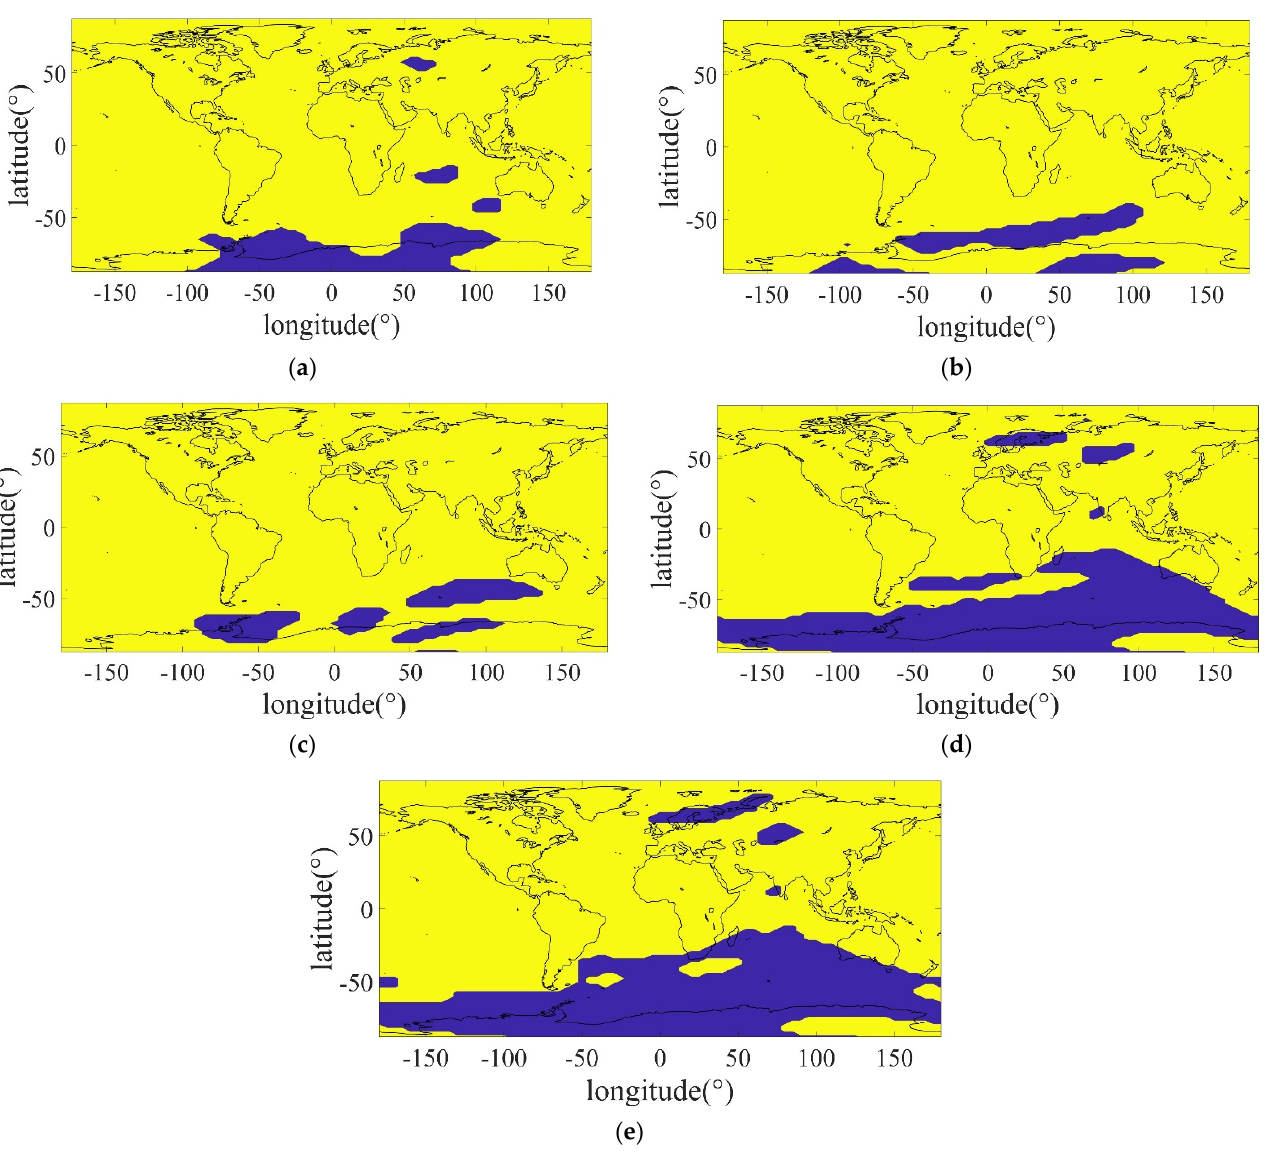
Figure 9. Region distribution of 0-value (blue region) of four systems at UT 0:00, DOY 213, 2021. ( a ) GPS; ( b ) GLONASS; ( c ) Galileo; ( d ) BDS; ( e ) BDS (MEO + IGSO). Table 1. The mean number of each system 0-value in different areas during ionosphere quiet days (DOY 213–242 in 2021).